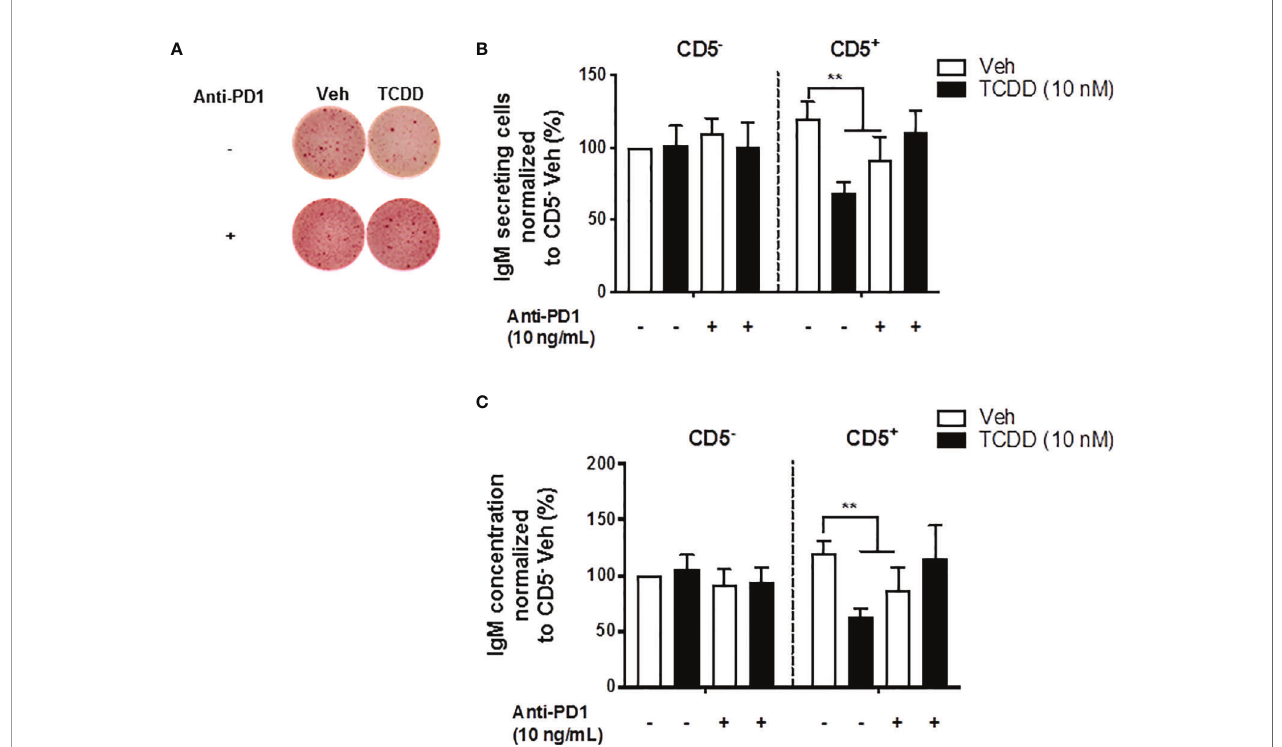
FIGURE 8 | PD-1 antibody blockade prevented TCDD-mediated suppression of the IgM response in human CD5 + ILBs. Human CD5+/- B cells were isolated, activated, and treated with Veh or TCDD as described previously. To determine the contribution of PD-1 to TCDD-mediated IgM suppression, 10 ng/mL anti-PD-1 blocking antibody (S228P) was added to CD5 +/- B cell cultures. Following 7 days of culture, cells and culture supernatants were collected and assessed for IgM secretion. (A) Representative ELIspot wells showing the number of IgM secreting cells within CD5 +/- populations with or without anti-PD-1 treatment; (B) Averaged number of IgM secreting cells; and (C) Averaged IgM concentration from CD5 +/- culture supernatants. Determinations were made using B cells from 7 human donors (N = 7) across three independent experiments. Data presented in the fi gure were normalized to CD5 - Veh without anti-PD-1 treatment. Signi fi cant differences are indicated by ** p < 0.01 (two-way ANOVA following with Fisher ’ s LSD post hoc